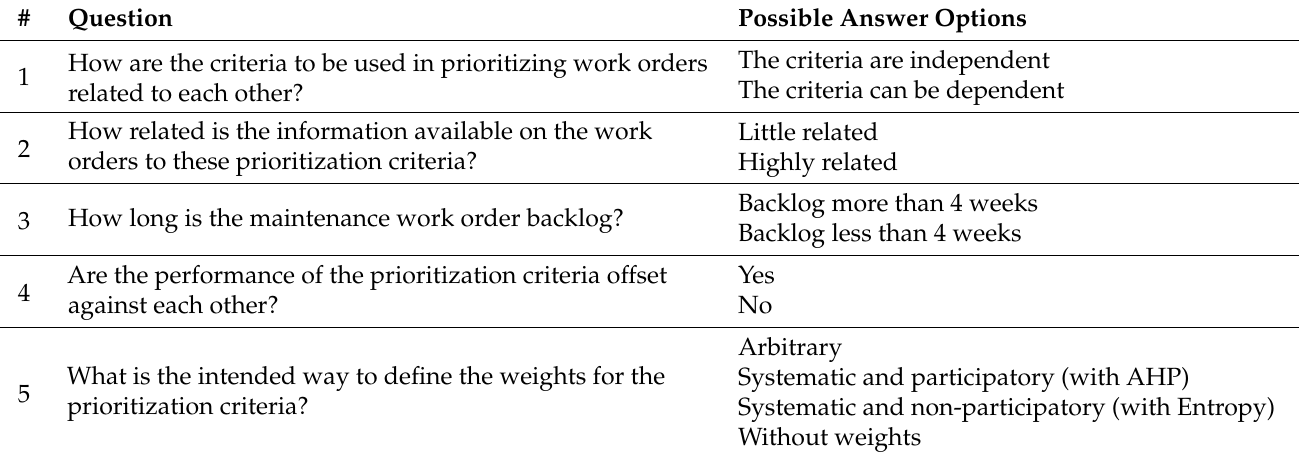
Figure 2. The proposed decision tree diagram. Table 3. Questions and possible answers in the proposed decision